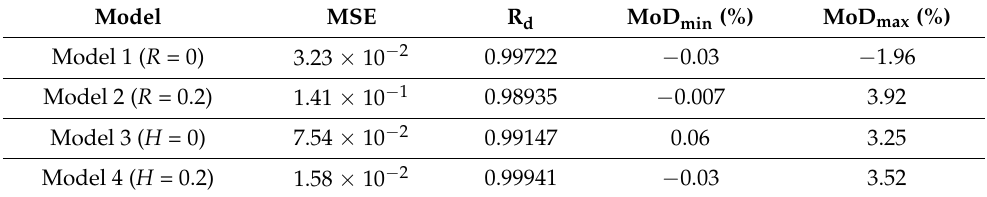
Table 16. Comparison of skin friction coefficient with Ref. [31].